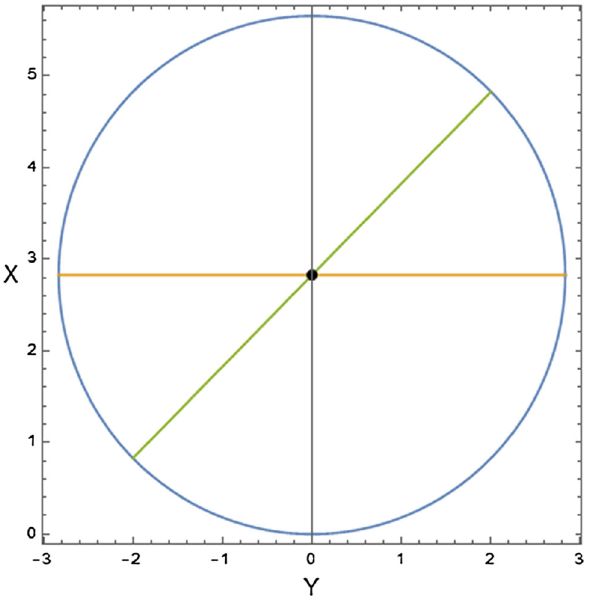
Fig. 2 Projection of the 3-sphere in Euclidean space (blue) onto the X - Y -plane for c = 1 ( l 0 = 4). The black dot is at the center ( l 0 / of the sphere with radius r = l 0 / shown (green and orange), see also